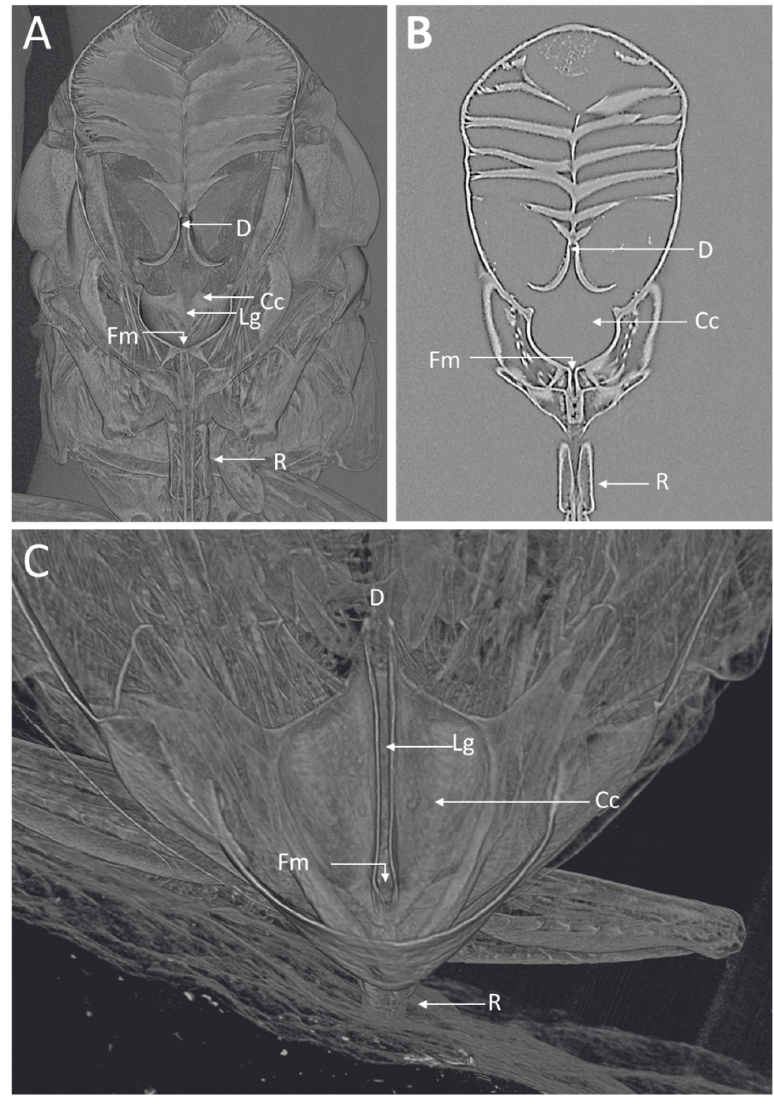
Figure 2. MicroCT images of the GWSS head virtually dissected to expose the foregut and cibarium region. The 3D ( A ) and 2D ( B ) microCT images clearly show various structural details where Xylella fastidiosa is known to accumulate and form biofilms. ( C) 3D microCT volume rendering for a close ‐ up of the cibarium area. D, diaphragm; Lg, longitudinal groove; Cc, cibarium chamber; Fm, food meatus; R, rostrum.